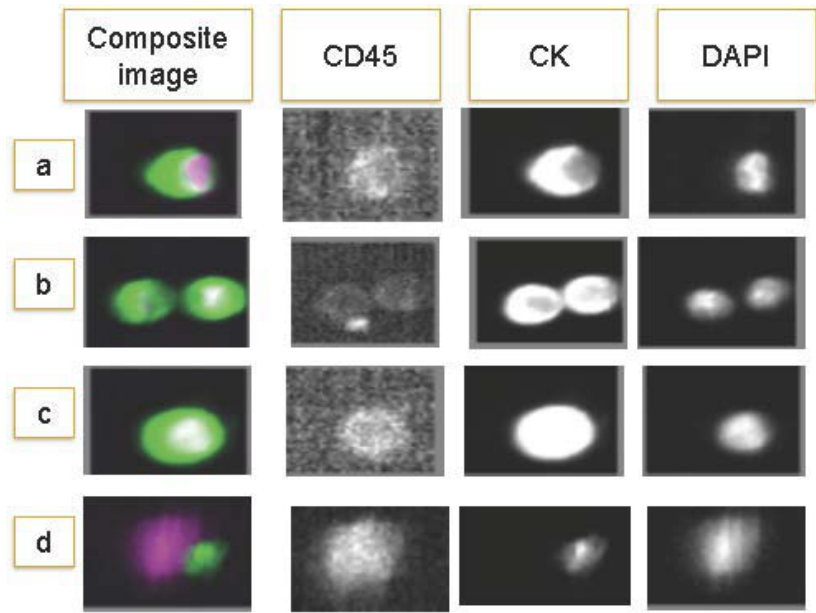
Figure 1. CTC as detected by CellSearch™: differential staining following EpCAM ferrofluid cell capture allows identification of CTC. Staining panel: CD45 leukocyte specific cell surface marker; CK (cytokeratin 8,18,19) epithelial marker; DAPI: (4',6-diamidino-2-phenylindole) detecting nucleic acids. (a–c) CTC: CD45-, CK+, DAPI+; (d) non-CTC, potential leukocyte: CD45+, CK-, DAPI+. (Image provided by the Translational Research Unit, Hospital of